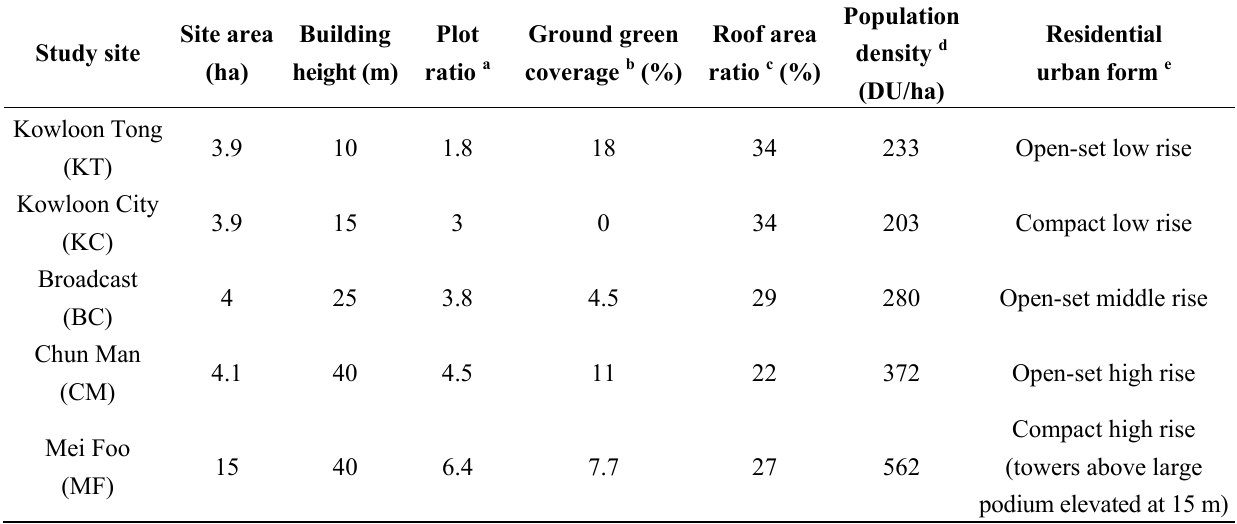
Table 1. Pertinent urban design parameters of the five study